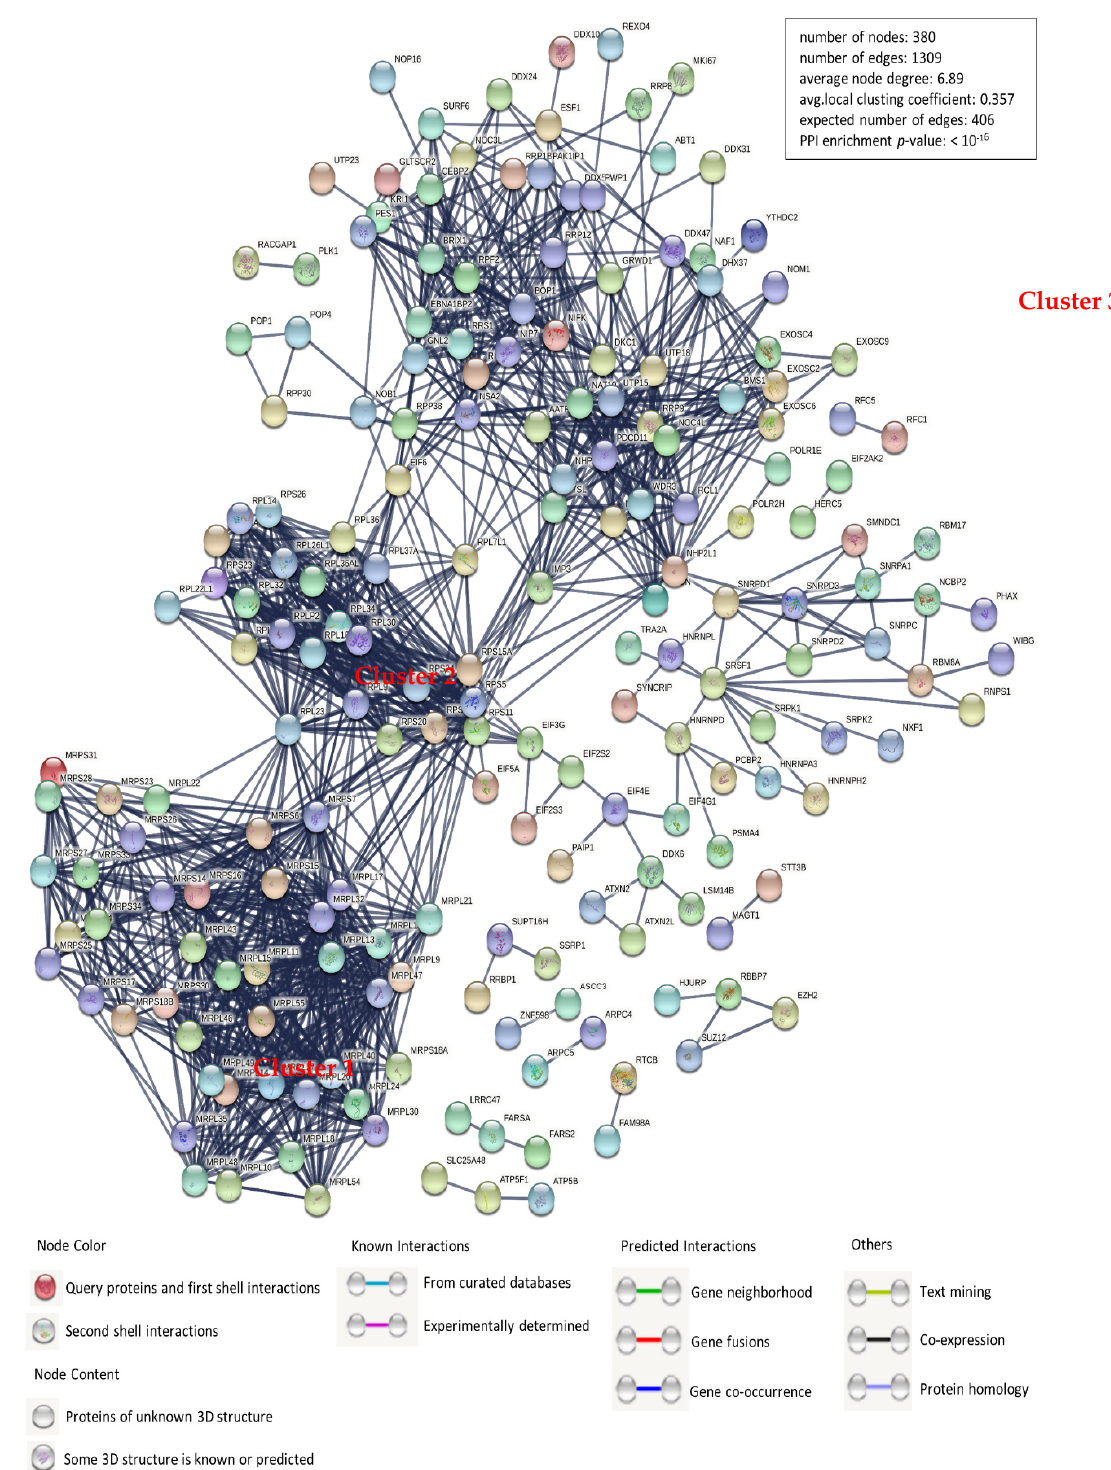
Figure 2. Construction and analysis of the protein–protein interaction network using the STRING database. Each edge color indicates a unique method of protein–protein interaction prediction, as indicated below the figure. A map of the interaction of PEDV N protein–interacting host proteins with the other proteins in our data was constructed and plotted using the network analyzer tool from Cytoscape software, version 3.7.1. The corresponding symbols indicating the different protein classes are shown in the figure. Proteins are represented by their respective NCBI gene names (Supplementary Table S2).